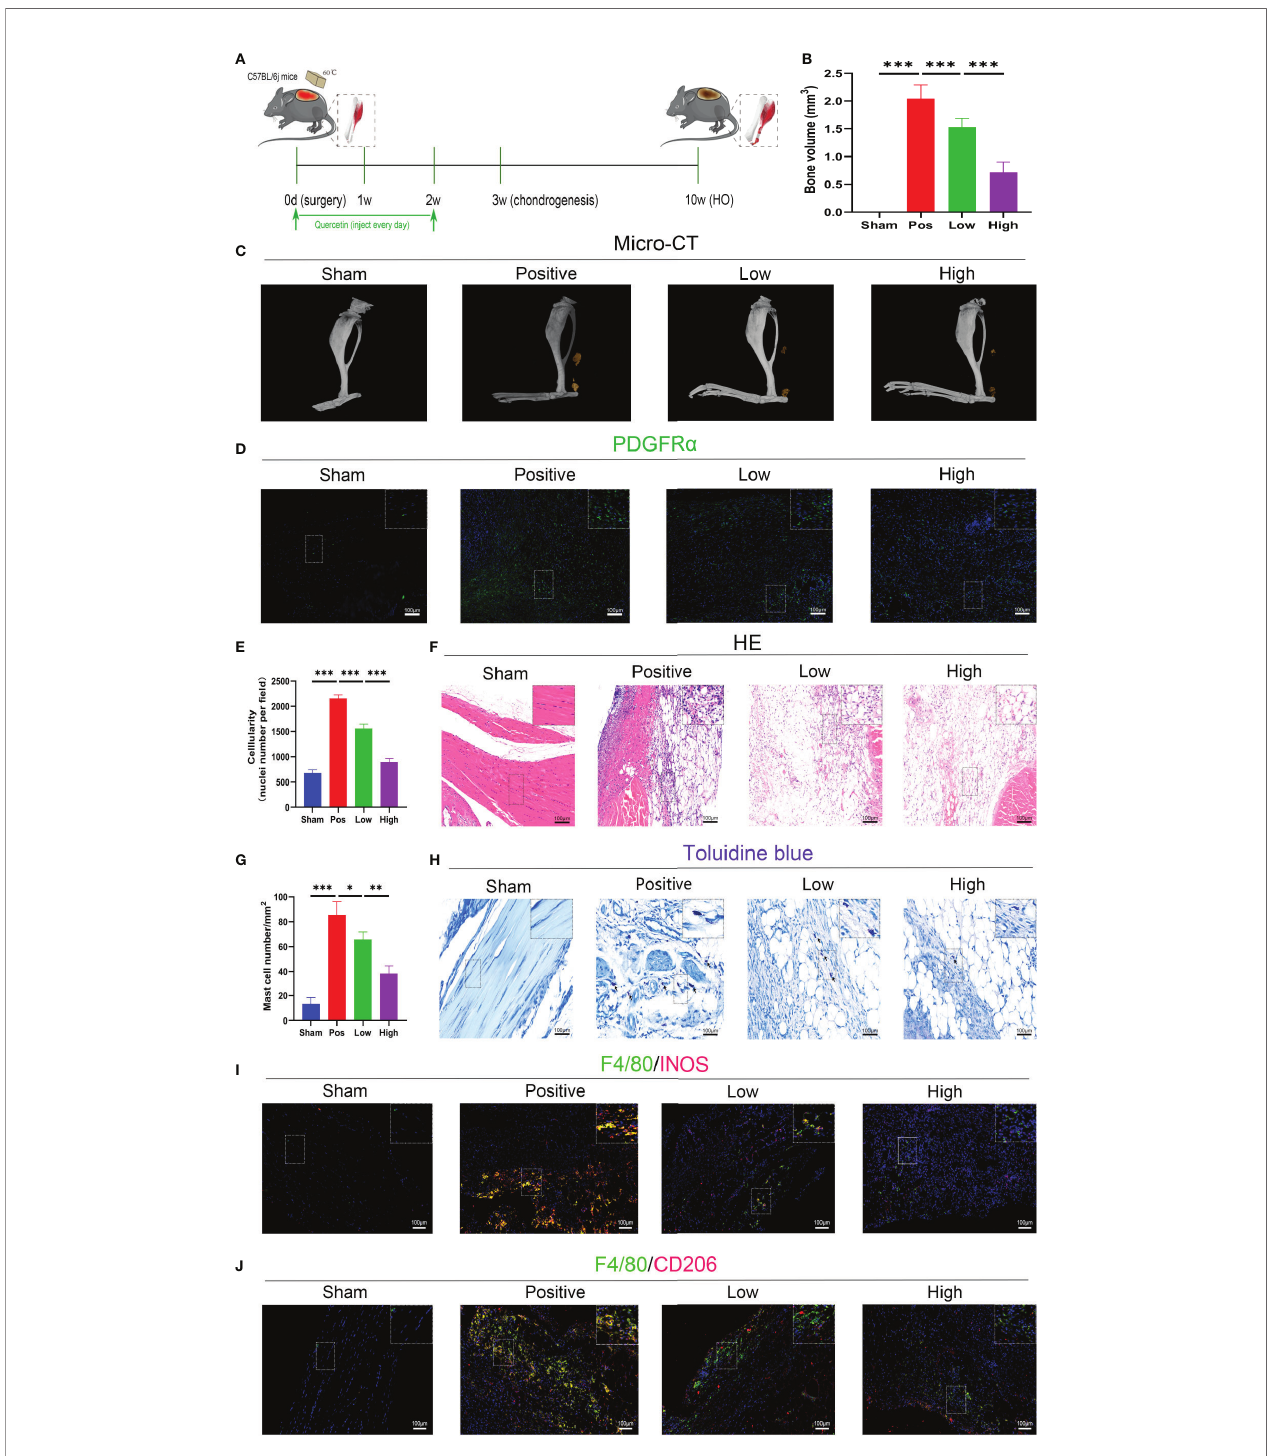
FIGURE 7 | Quercetin effectively attenuated HO formation by diminishing macrophage and mast cell in fi ltration after tendon injury. (A) Schematic depiction of the quercetin treatment protocols for animal experiments. (B, C) Micro-CT quanti fi cation and observation of HO formation. (D) Immuno fl uorescence staining of the stem cell marker PDGFR a 7 days after burn/tenotomy. (E, F) HE staining for observation of tissue cellularity 3 days after burn/tenotomy. (G, H) Toluidine blue staining for observation of mast cell accumulation 7 days after burn/tenotomy. (I) Double fl uorescence staining of F4/80 and INOS for observation of the M1 subtype of macrophages 7 days after burn/tenotomy. (J) Double fl uorescence staining of F4/80 and CD206 for observation of the M2 subtype of macrophages 7 days after burn/tenotomy. Original magni fi cation is 40x for toluidine blue staining and 20x for other staining. Inserts are approximately 3.5x magni fi ed images of the boxed area. N=4/group, *P < 0.05, **P < 0.01, ***P <